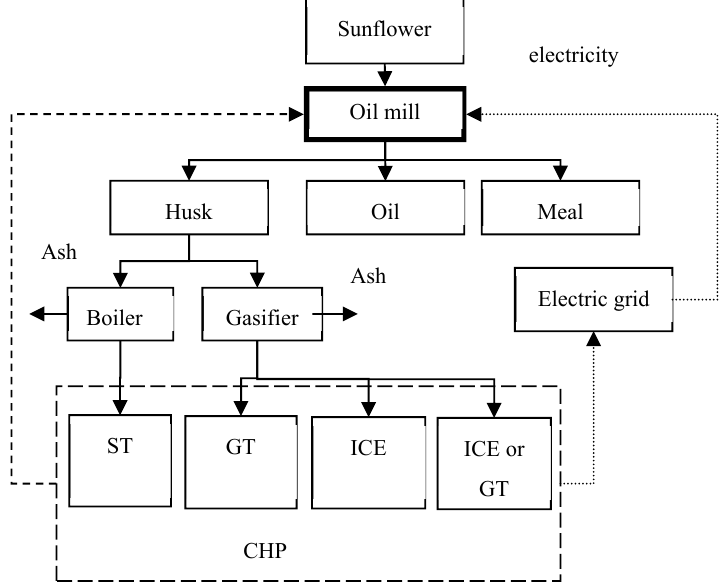
Figure 10. Energy supply technologies of Sunflower Seed Oil Mill (developed by author).